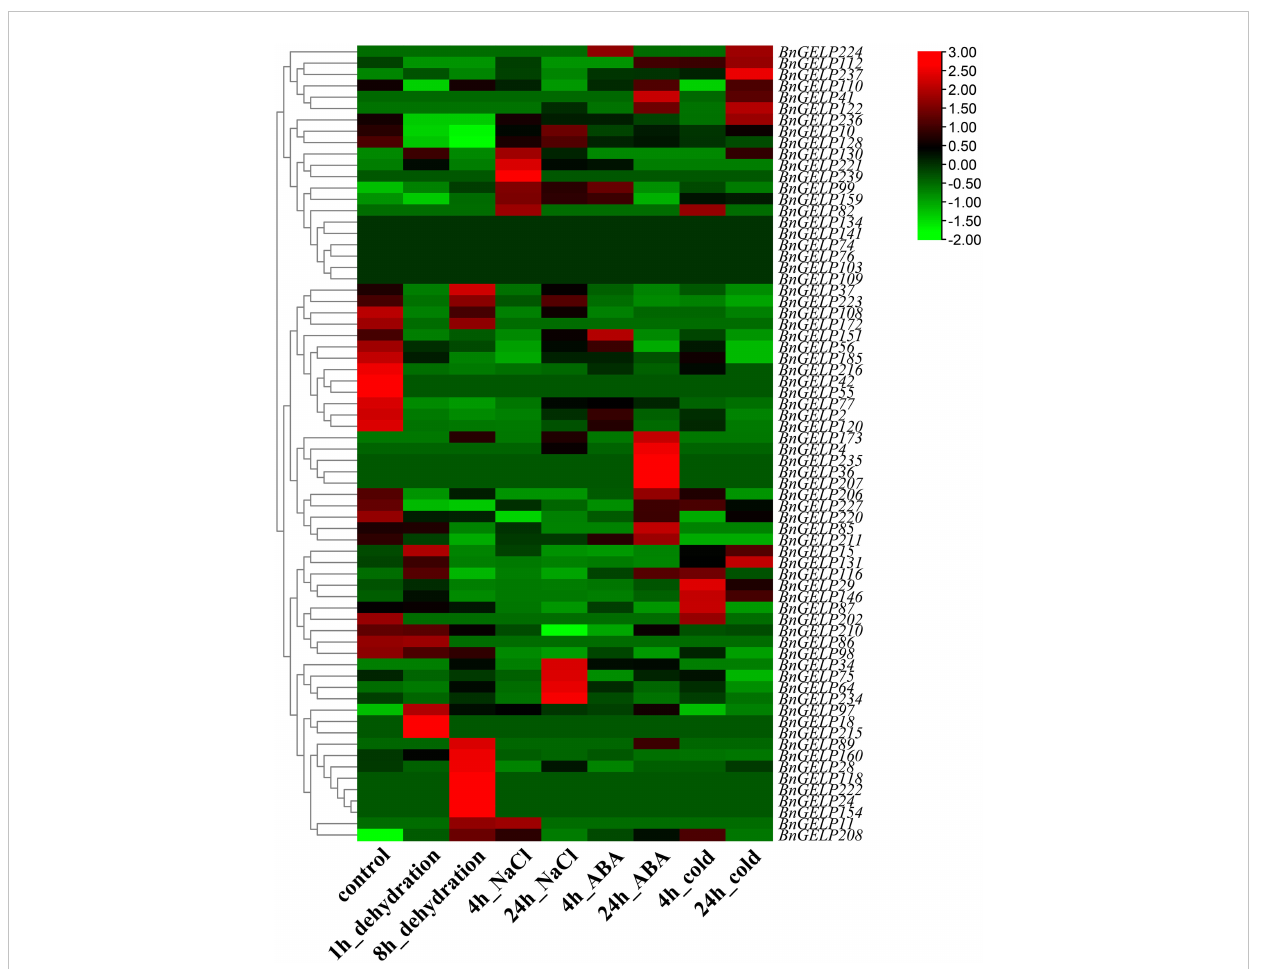
FIGURE 7 Expression pro fi les of the clade 5 BnGELP genes under different stresses. Transcript levels for the 70 BnGELP genes were obtained from public transcriptome data obtained from B . napus cultivar ZS11 under different abiotic stresses. Each relative expression level is equal to the mean values and transformed log 2 values for normalization. The color scale represents relative expression levels from low (green colored) to high (red